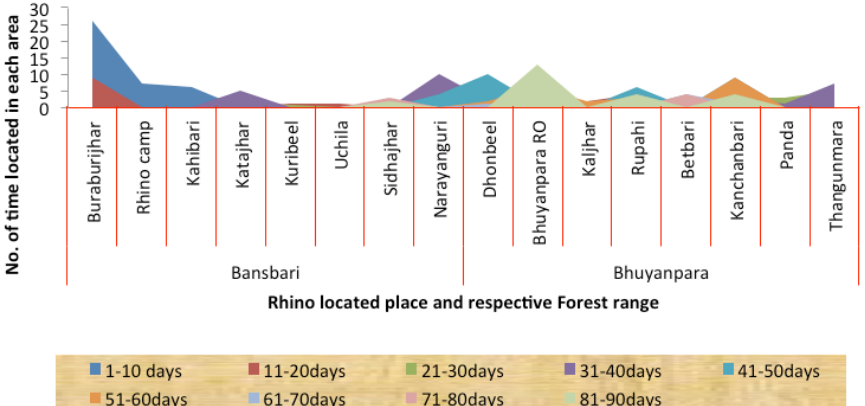
Figure 8. Colonization pattern of the 4 th group of